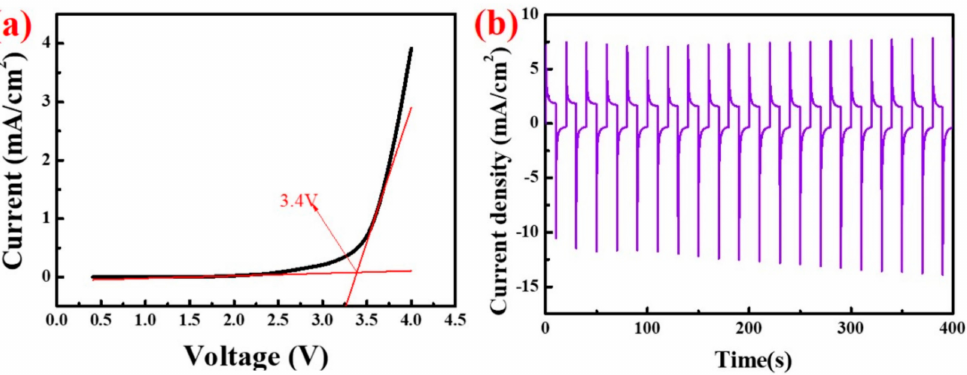
Figure 6. ( a ) Linear sweep volt-ampere curve of PADA-b gel electrolyte; ( b ) Chronoamperometry curve of the ECD (WO 3 -600) at a voltage of ± 3.0 V.